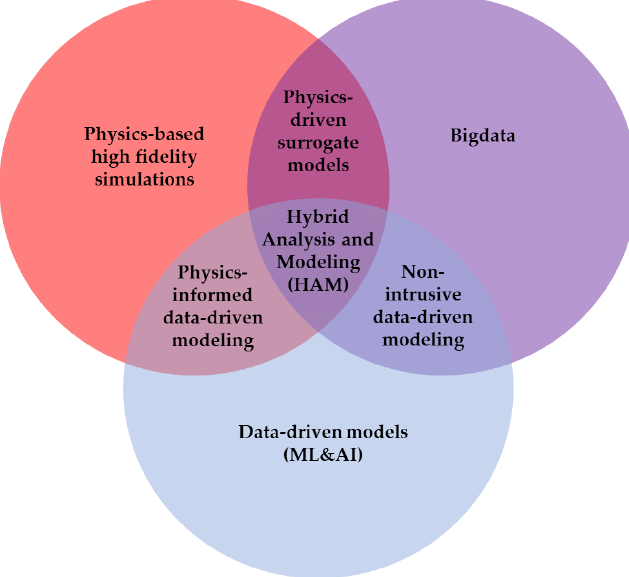
Figure 3. Combination of physics-based and data-driven modelling